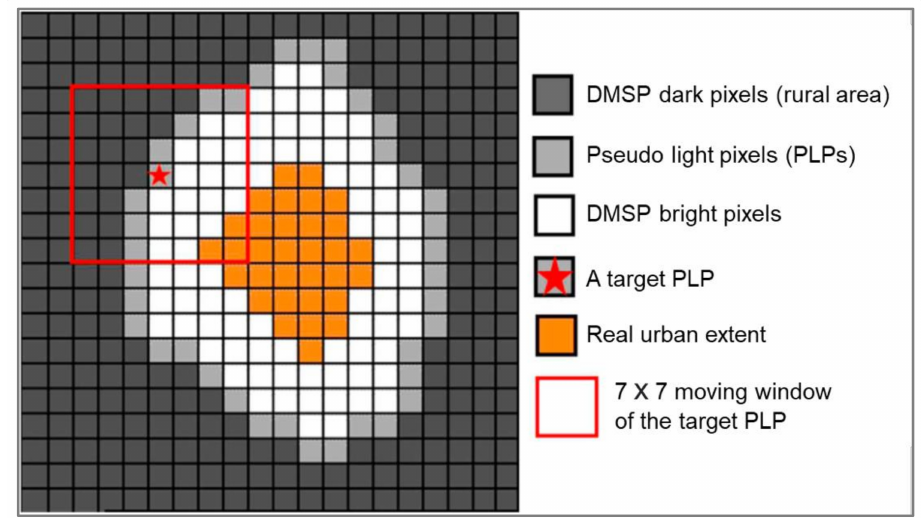
Figure 3. The selection of pseudo light pixels (PLPs) and their adjacent pixels within the frame of a 7 X 7 moving window [48] (p. 404).